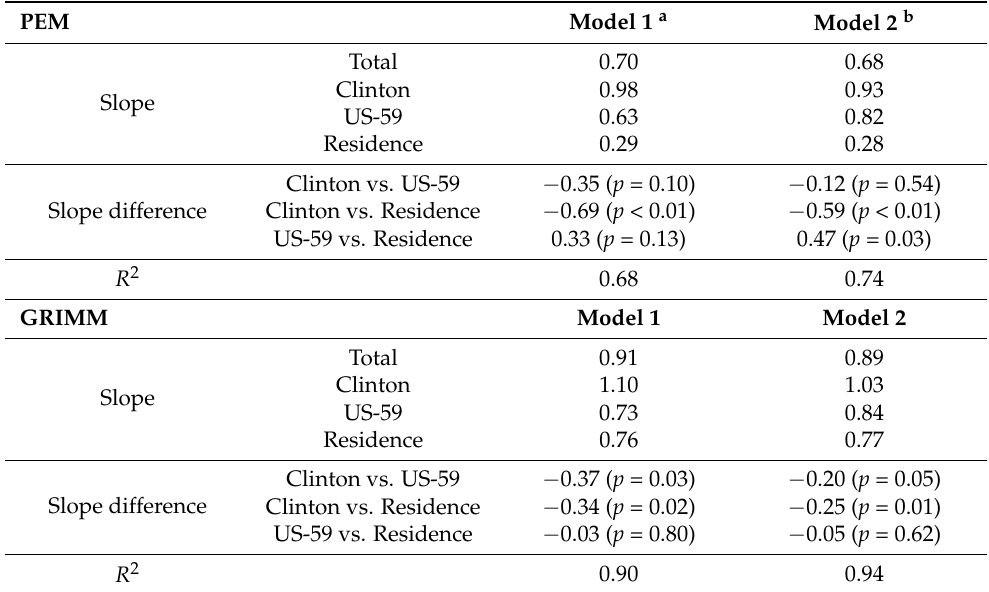
Table 2. Comparison of slopes obtained from regression models. PEM Model 1